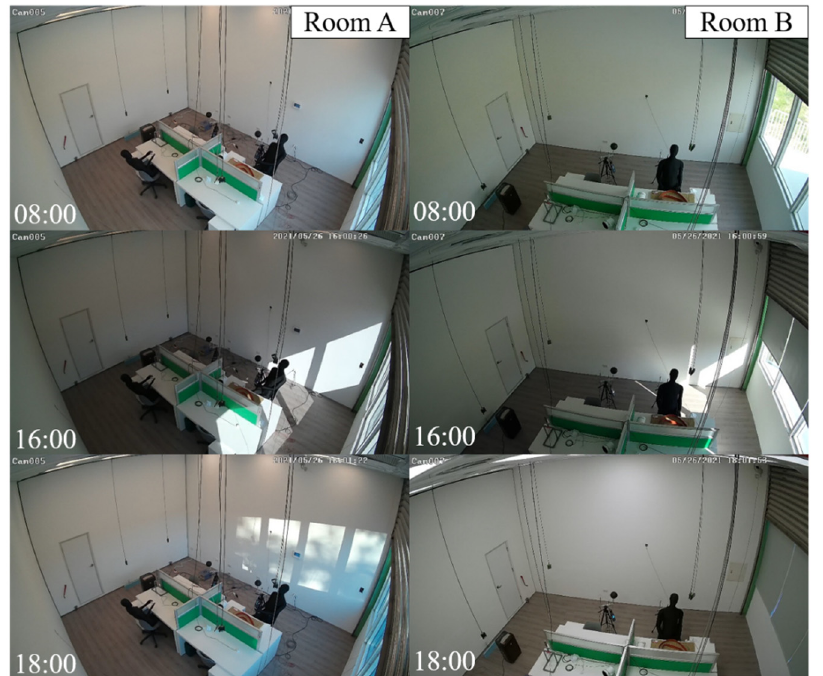
Figure 3. Laboratory internal status records.